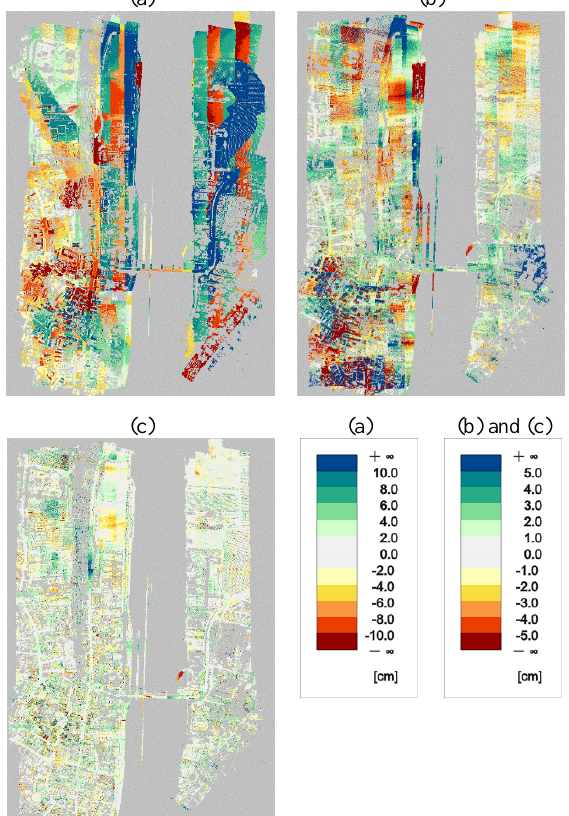
Figure 3. Relative strip differences of (a) raw data and after strip adjustment using trajectory corrections with (b) bias model and (c) spline